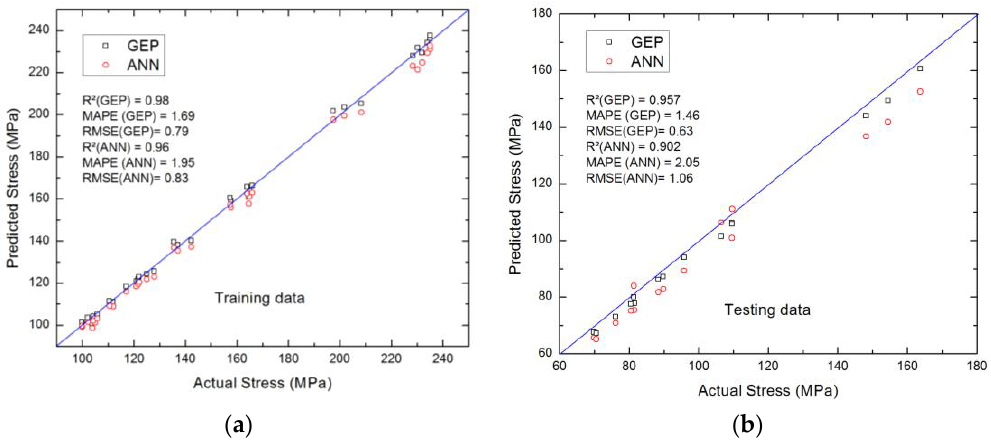
Figure 7. Performance of FEM-GP model and ANN of true stress of AZ31 for ( a ) training data and ( b ) testing data. R 2 : coefficient of determination; MAPE: mean absolute percentage error; RMSE: root mean square error; GP: Genetic Programming; ANN: Artificial Neural Network.